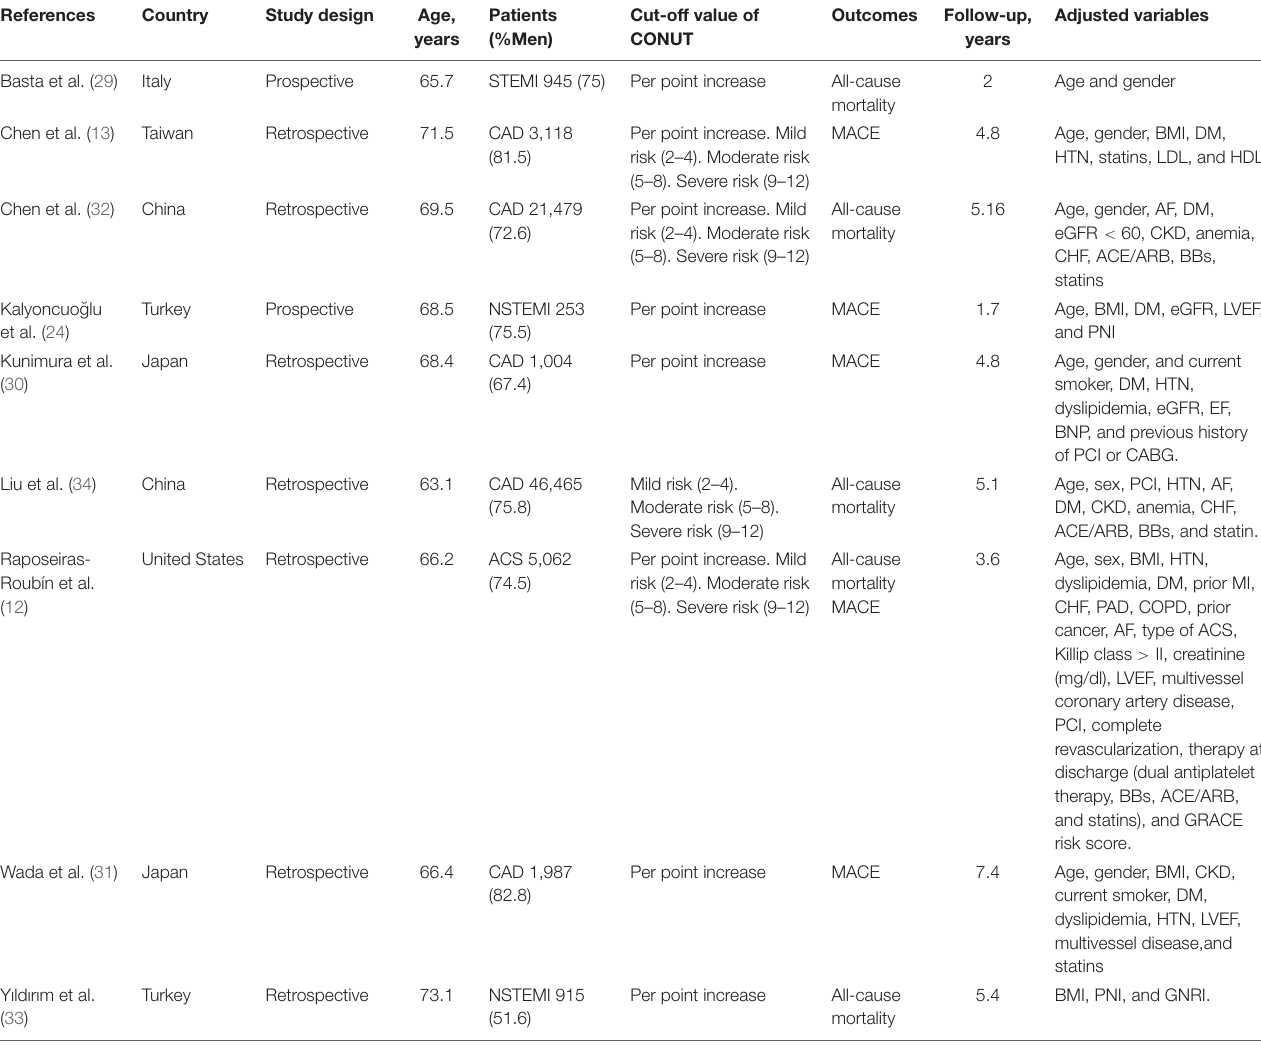
TABLE 1 | Main characteristic of the included studies.